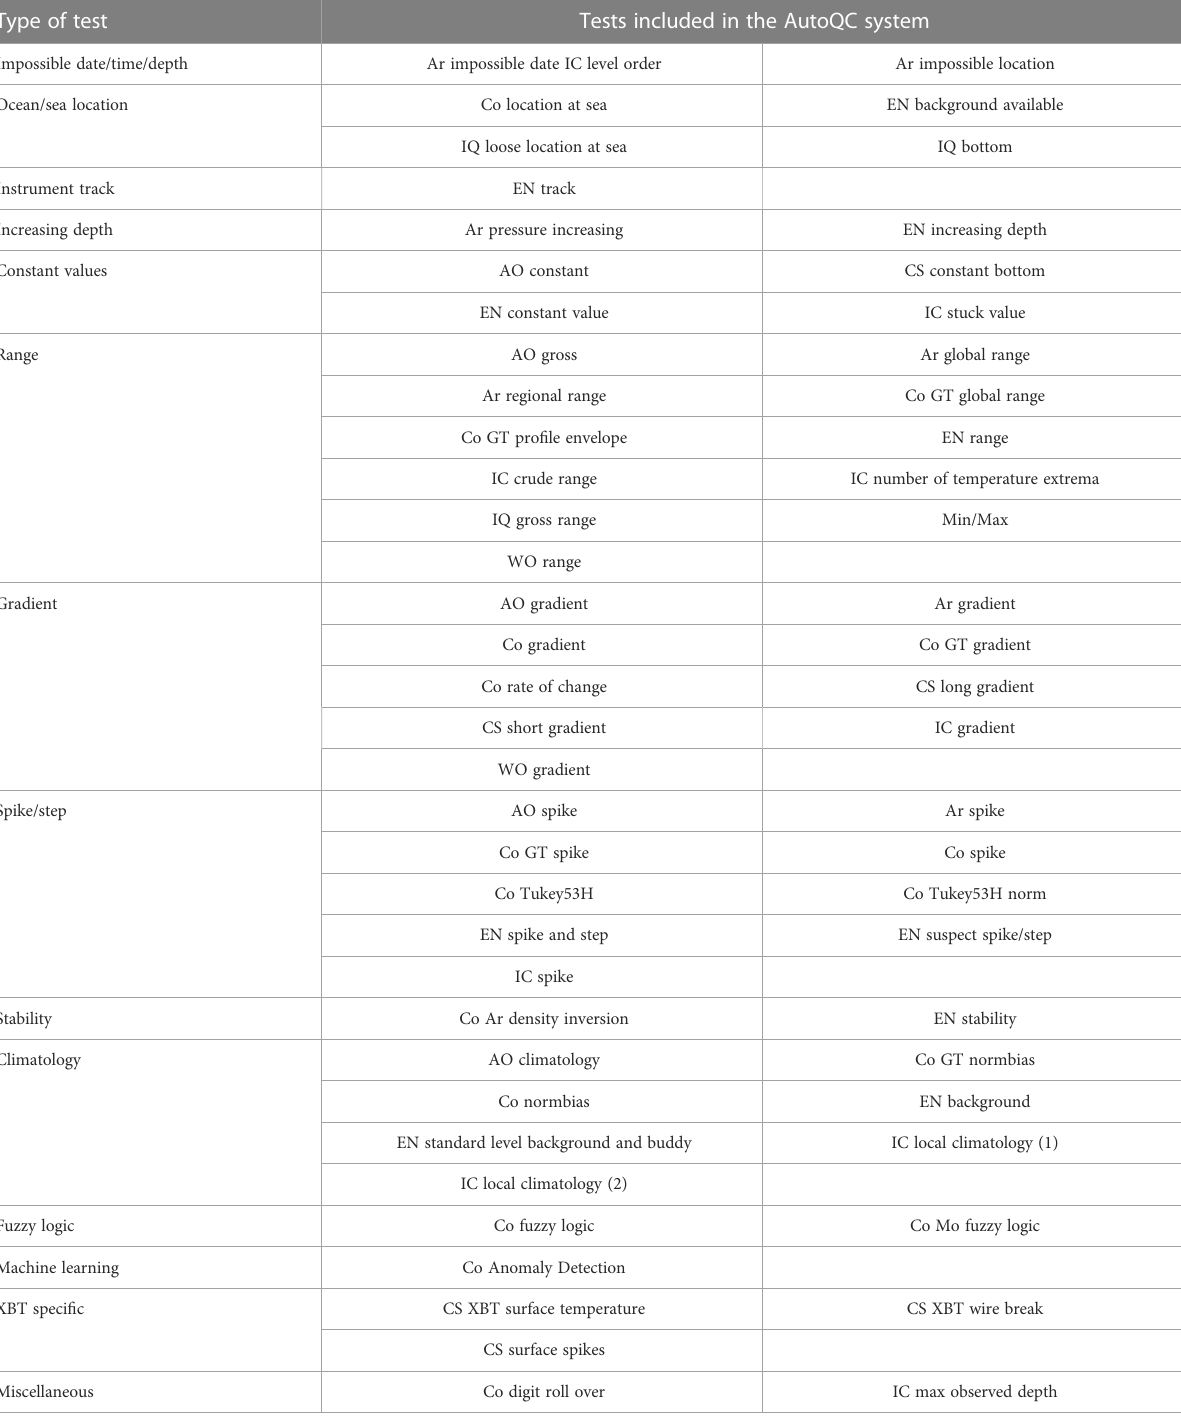
TABLE 1 List of types of QC checks and the individual tests that have been included in this